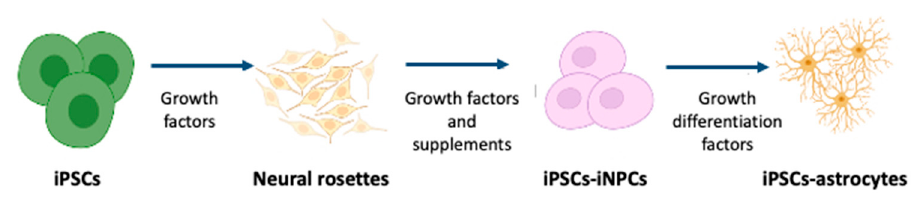
Figure 1 schematizes this four-step process.